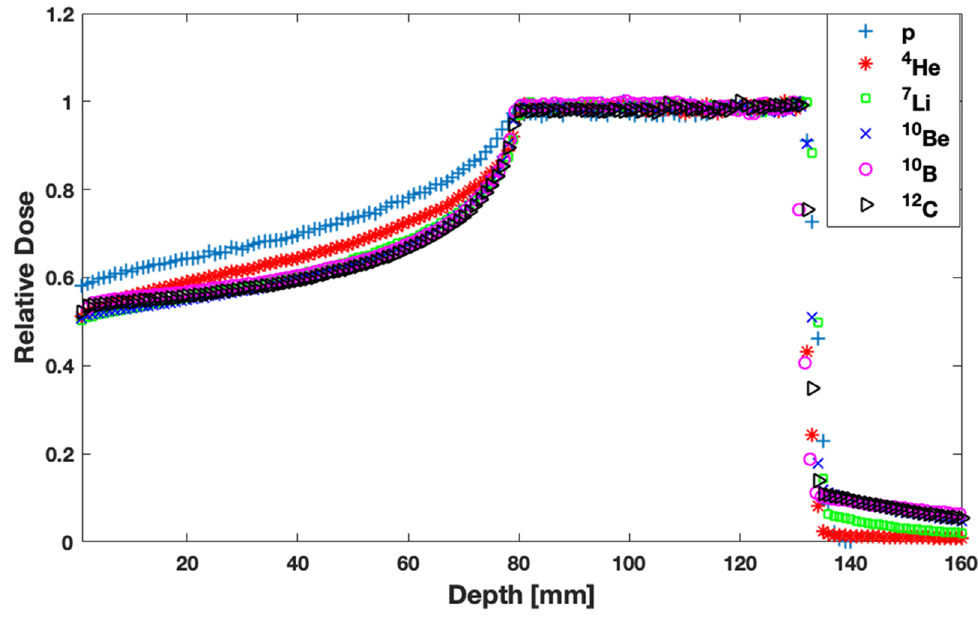
Figure 5. Biologically optimized percentage depth-dose curves for all ion beams considered in this study.